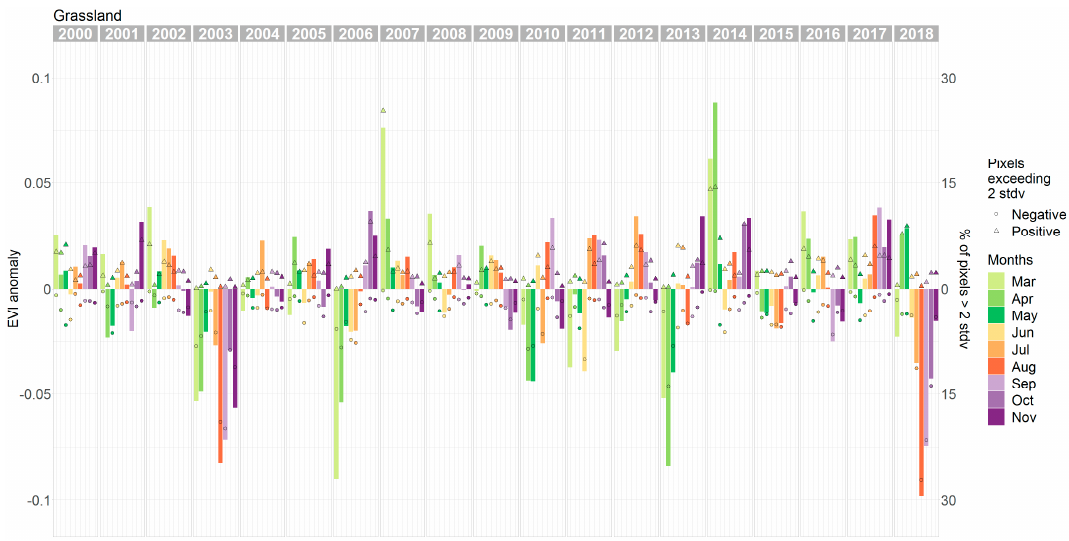
Figure 6. Monthly averaged EVI anomalies for grassland and percentage of pixels with EVI deviances exceeding two standard deviations (pixel-based) positively and negatively per month for Germany for the years 2000–2018 for grassland.